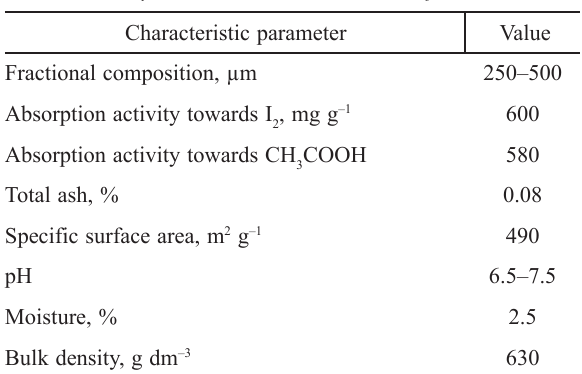
Table 1 – Physicochemical characteristics of